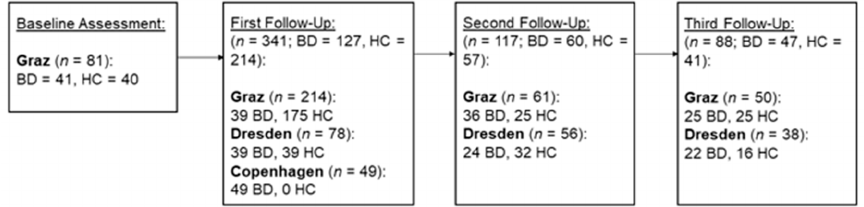
Figure 1. Overview of the sample sizes at each measurement time. Note. BD = Bipolar disorder, HC = Healthy controls.